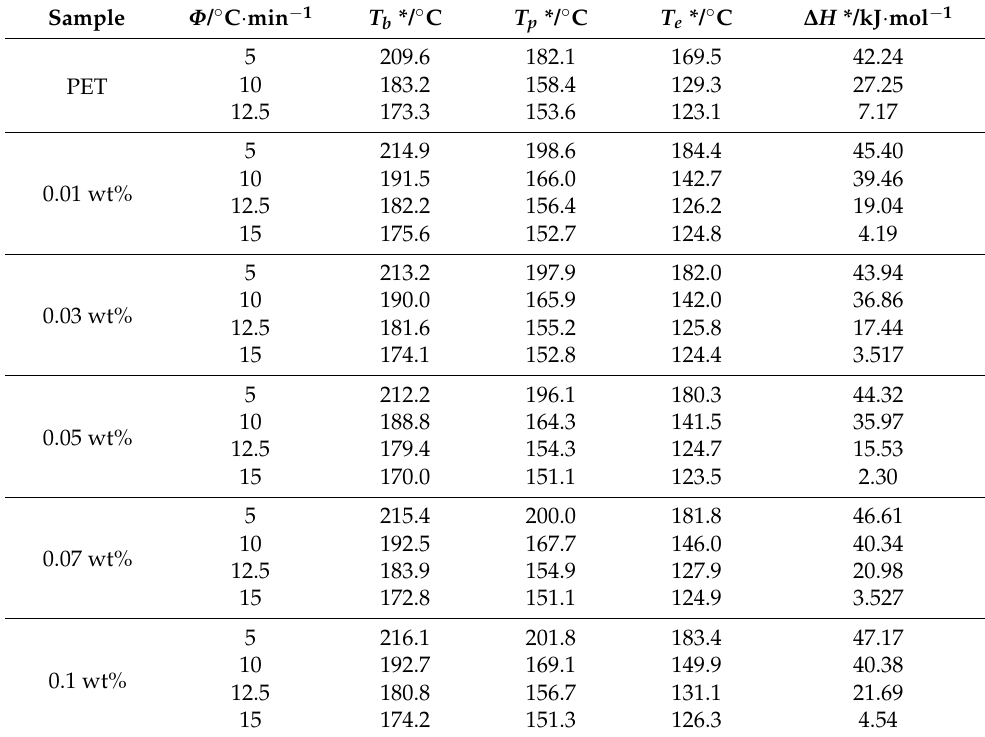
Table 1. Non-thermal crystallization parameters of PET and modified PET at different cooling